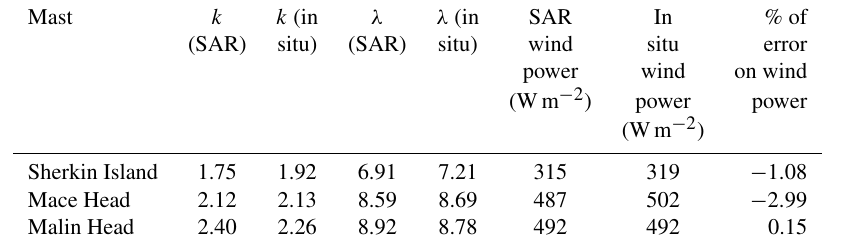
Table 10. Comparison of the long-term wind speed statistics produced from the coastal weather station data with those produced from the SAR data. These values evaluate the accuracy of the satellite-derived data to provide the correct long-term average wind statistics. Mast k k (in λ λ (in SAR In % of (SAR) situ) (SAR) situ) wind situ error power wind on wind (Wm − 2 ) power power (Wm − 2 ) Sherkin Island 1.75 1.92 319 Mace Head Malin Head 0.15